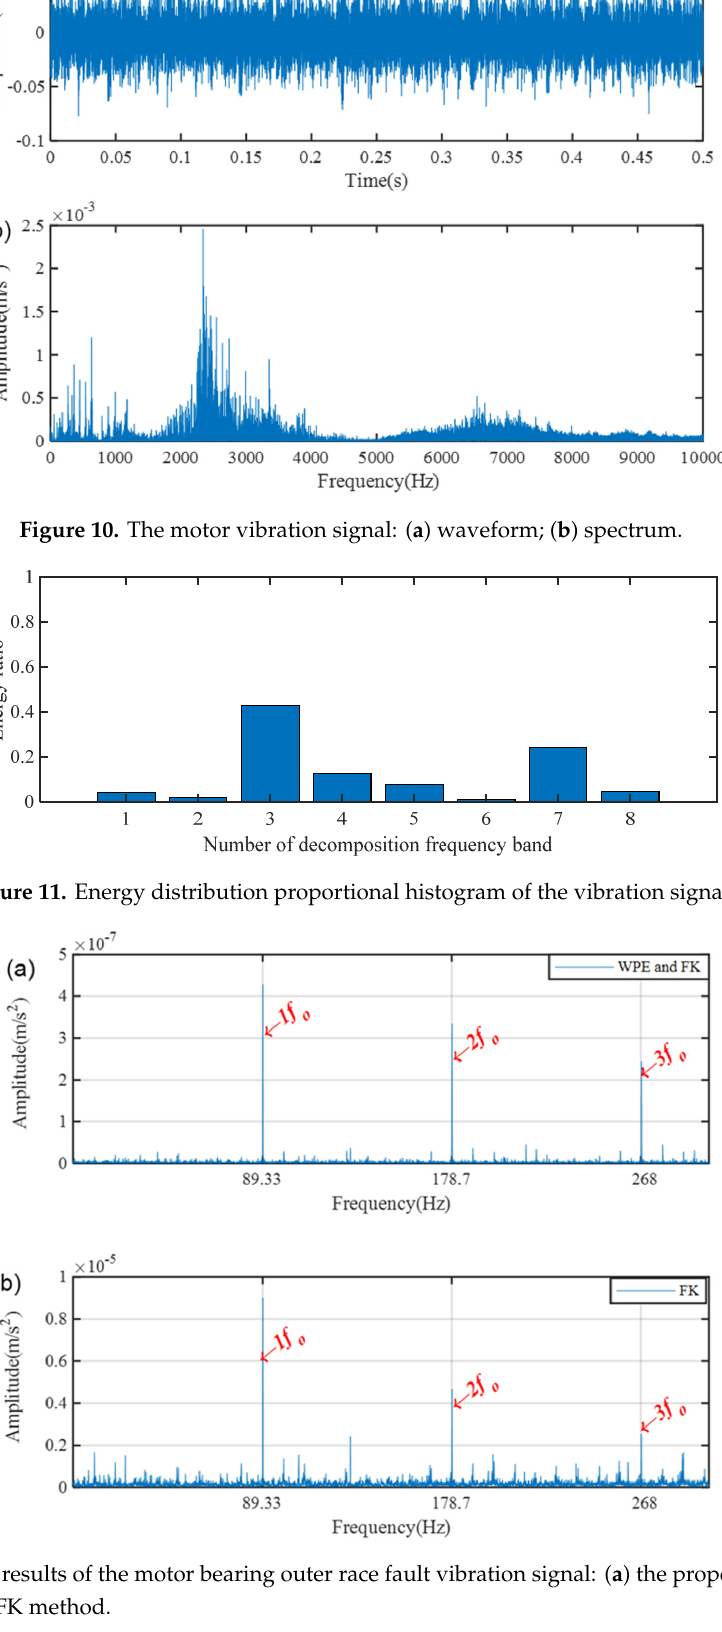
Figure 13. The supporting bearing vibration signal: ( a ) waveform; ( b ) spectrum.